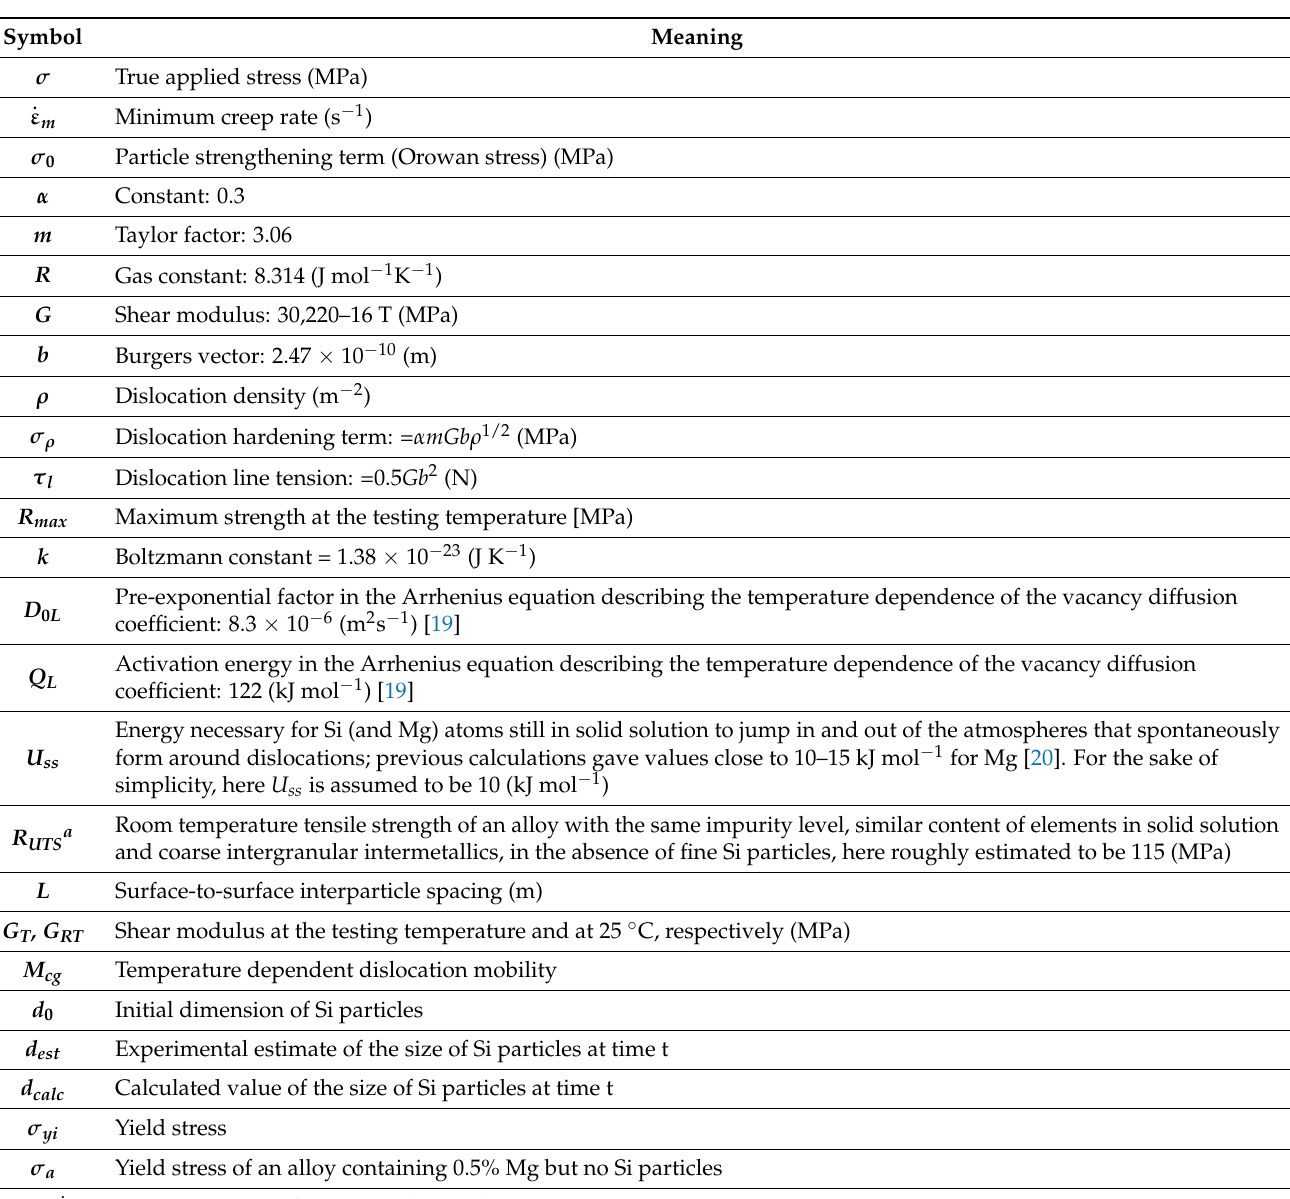
Table 1. List of constitutive model